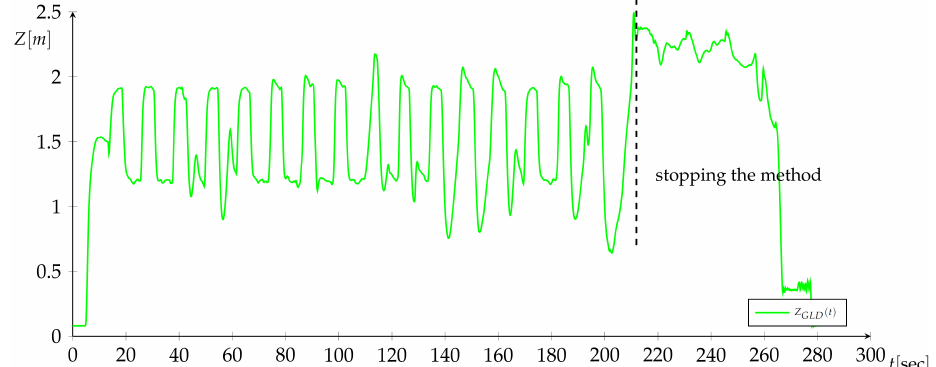
Figure 21. Values of J ( i ) in consecutive steps (i) of the GLD method (Exp. no. 1) – flying with the payload.